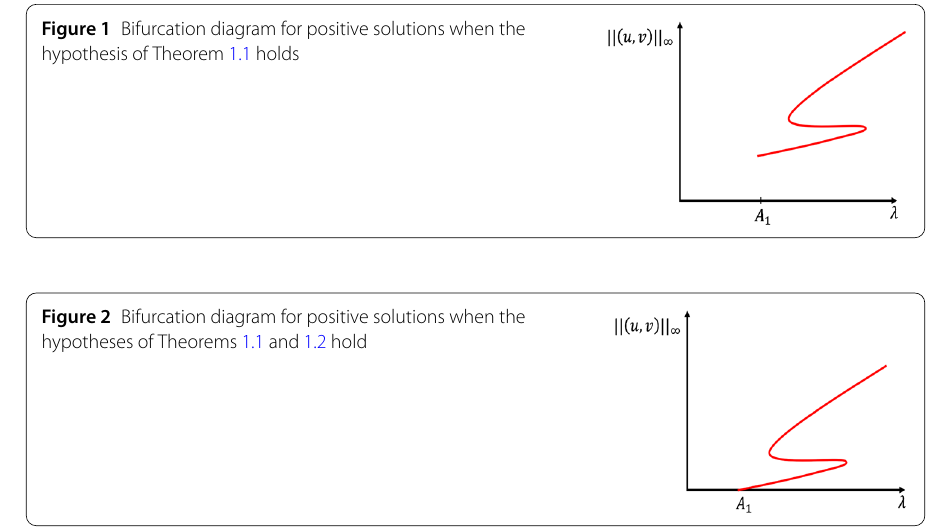
Figure 2 Bifurcation diagram for positive solutions when the hypotheses of Theorems 1.1 and 1.2